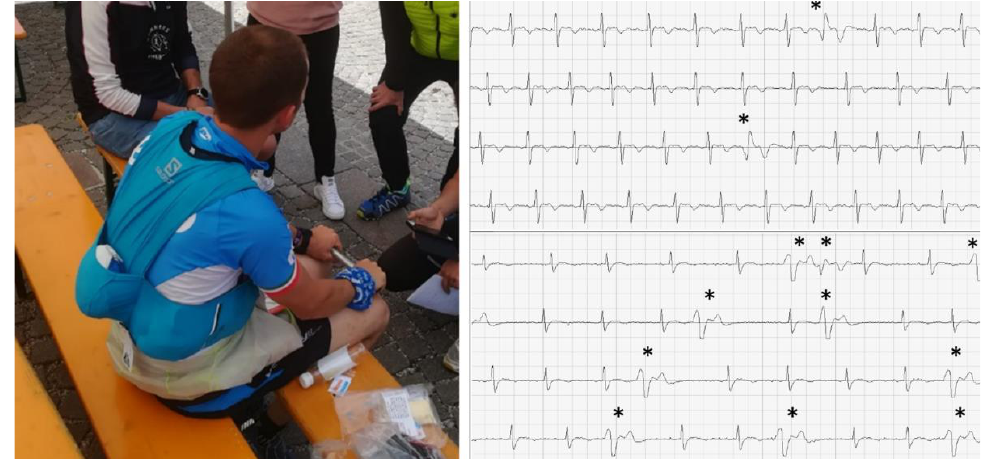
Figure 2. Example of two post-run ECG recordings with a portable single-lead electrocardiogram device showing premature ventricular beats (*) that were not present before the race. Reproduced with permission from Zorzi et al. [39].